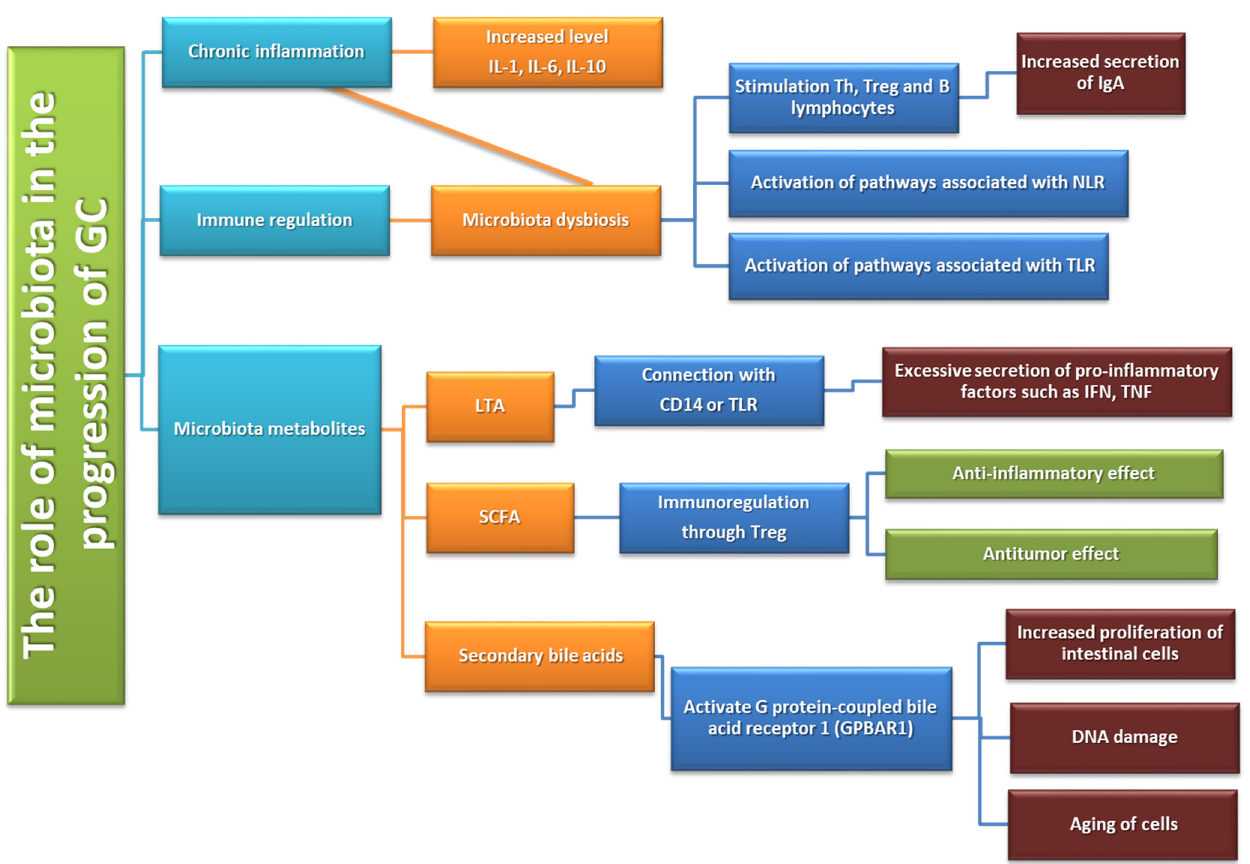
Figure 8. Immune system dysfunction in GC development and progression based on [111].